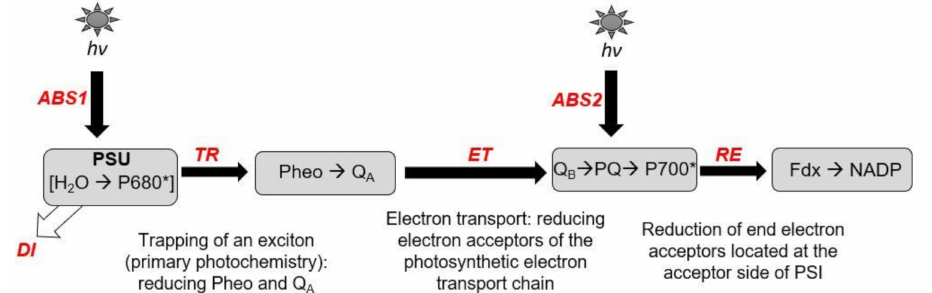
Figure 1. Schematic illustration of the photosynthetic events analyzed by the JIP-test. Dark arrows indicate the flow of the sequential energy fluxes from the absorbance (ABS1, ABS2) of the photons by the photosystem II (PSII) antenna molecules followed by the trapping flux (TR), photosynthetic electron transport flux (ET), and reduction of the end electron acceptors at the PS I electron acceptor side (RE). Formulae and glossary of terms used by the JIP-test are listed in Supplementary Table S1. DI, dissipation; Fdx, ferrodoxin; NADP, nicotinamide adenine dinucleotide phosphate; PSU, photosynthetic unit; Q A , quinone-A; Q B ,